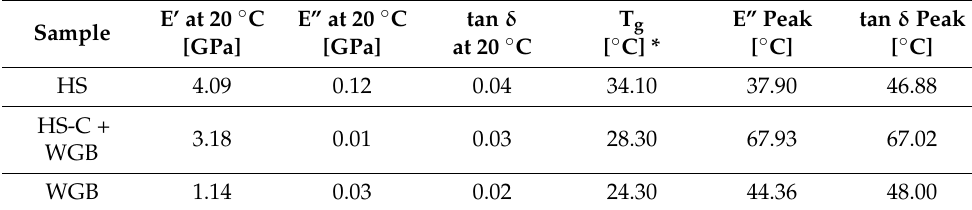
Table 2. Storage modulus (E’), loss modulus (E”), and tangent delta (tan δ ) at 20 ◦ C and glass transition temperature T g , loss modulus (E”) peak temperature, and tangent delta (tan δ ) peak temperature of samples HS, HS-C + WGB, and